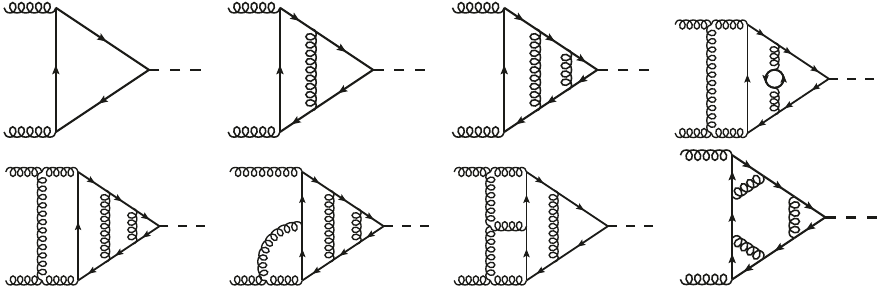
Figure 2 . Sample one-, two-, three- and four-loop diagrams contributing to the ggH amplitude. Solid and curly lines refer to fermions and gluons, respectively. The external Higgs boson is repre- sented by a dashed